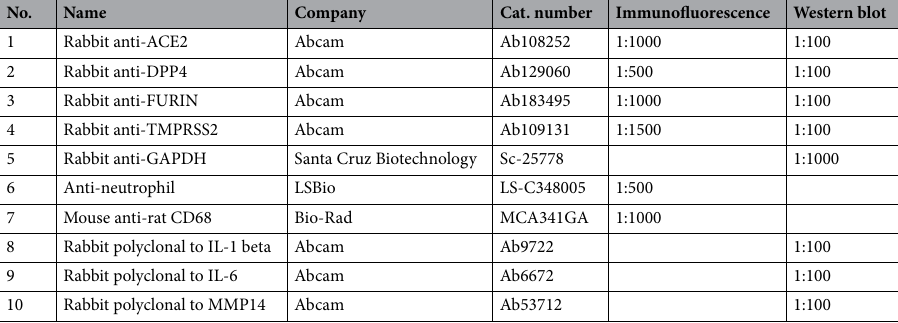
Table 1. List of primary antibodies used in this